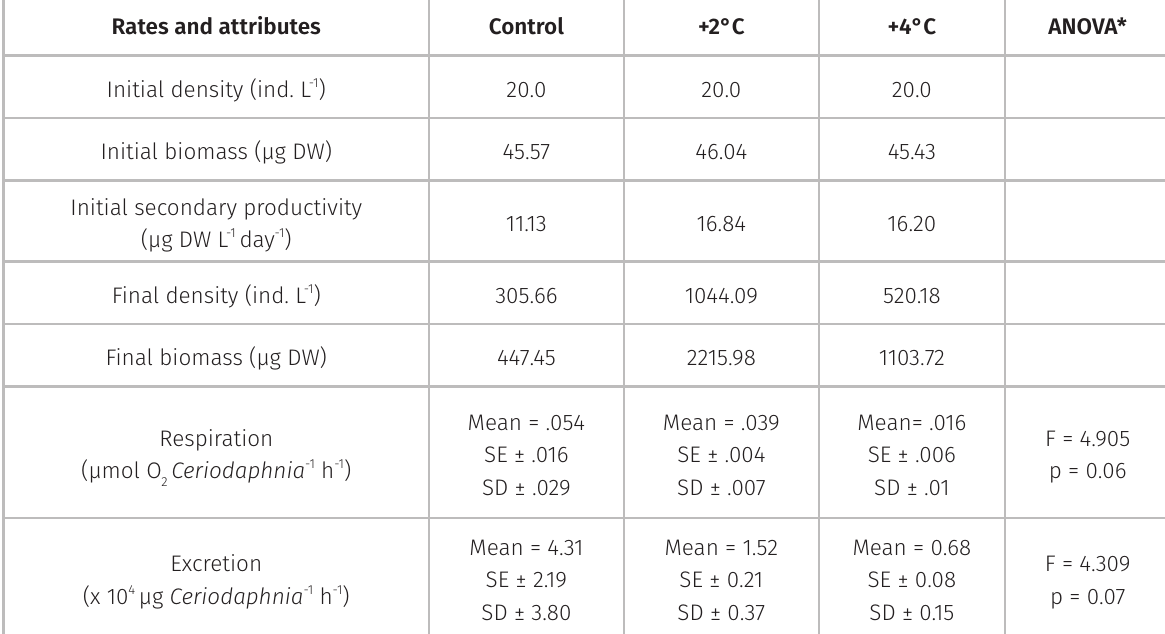
Table I. Initial and final average of C. silvestrii population rates, respiration, and excretion rates in the different temperatures. Note: ind. = individual. DW = dry weight. SE = standard error and SD = standard deviation. *Non- significant